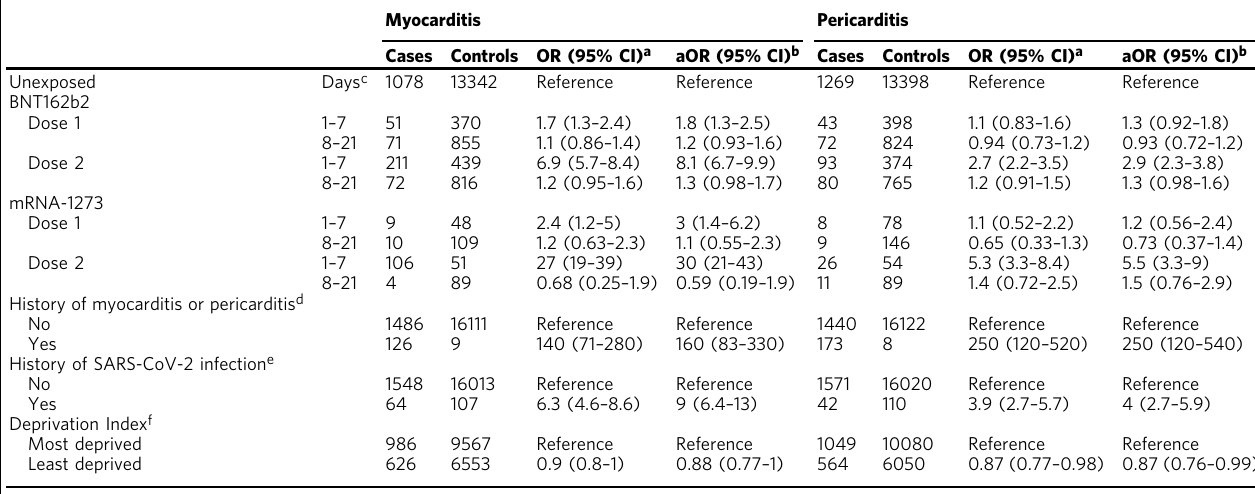
Table 2 Association between myocarditis and pericarditis and exposure to mRNA vaccines within 1 to 7 days and 8 to 21 days.